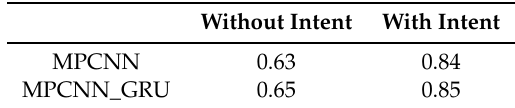
Table 7. Semantic matching results on baseline for user question.